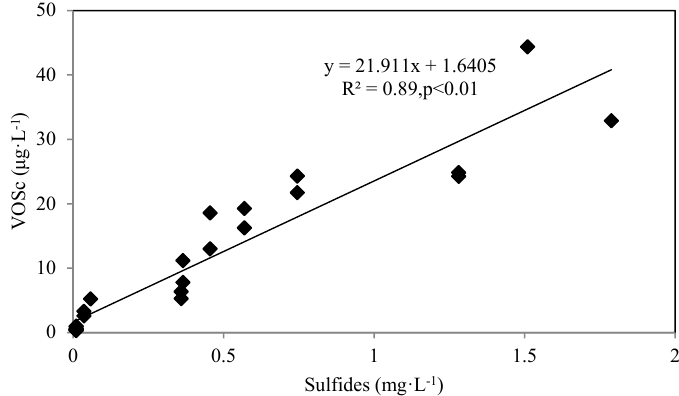
Figure 4. Seasonal variation of sulfides ( a ) and VOSc; ( b ) at different water layer in the Zhoucun Reservoir.